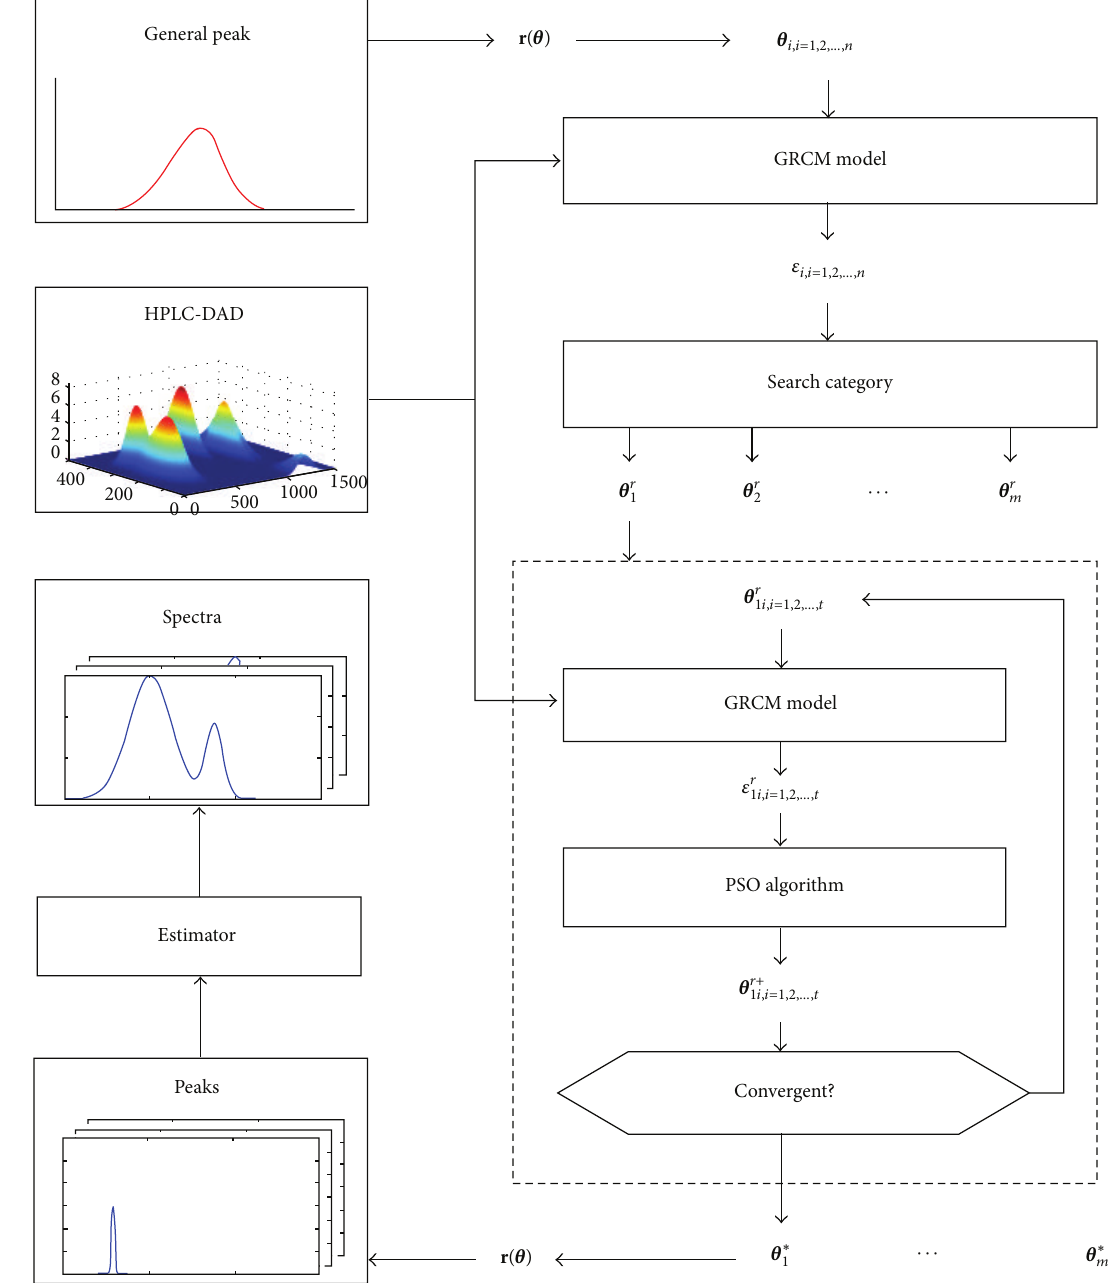
Figure 2: Principle of the GRCM-PSO